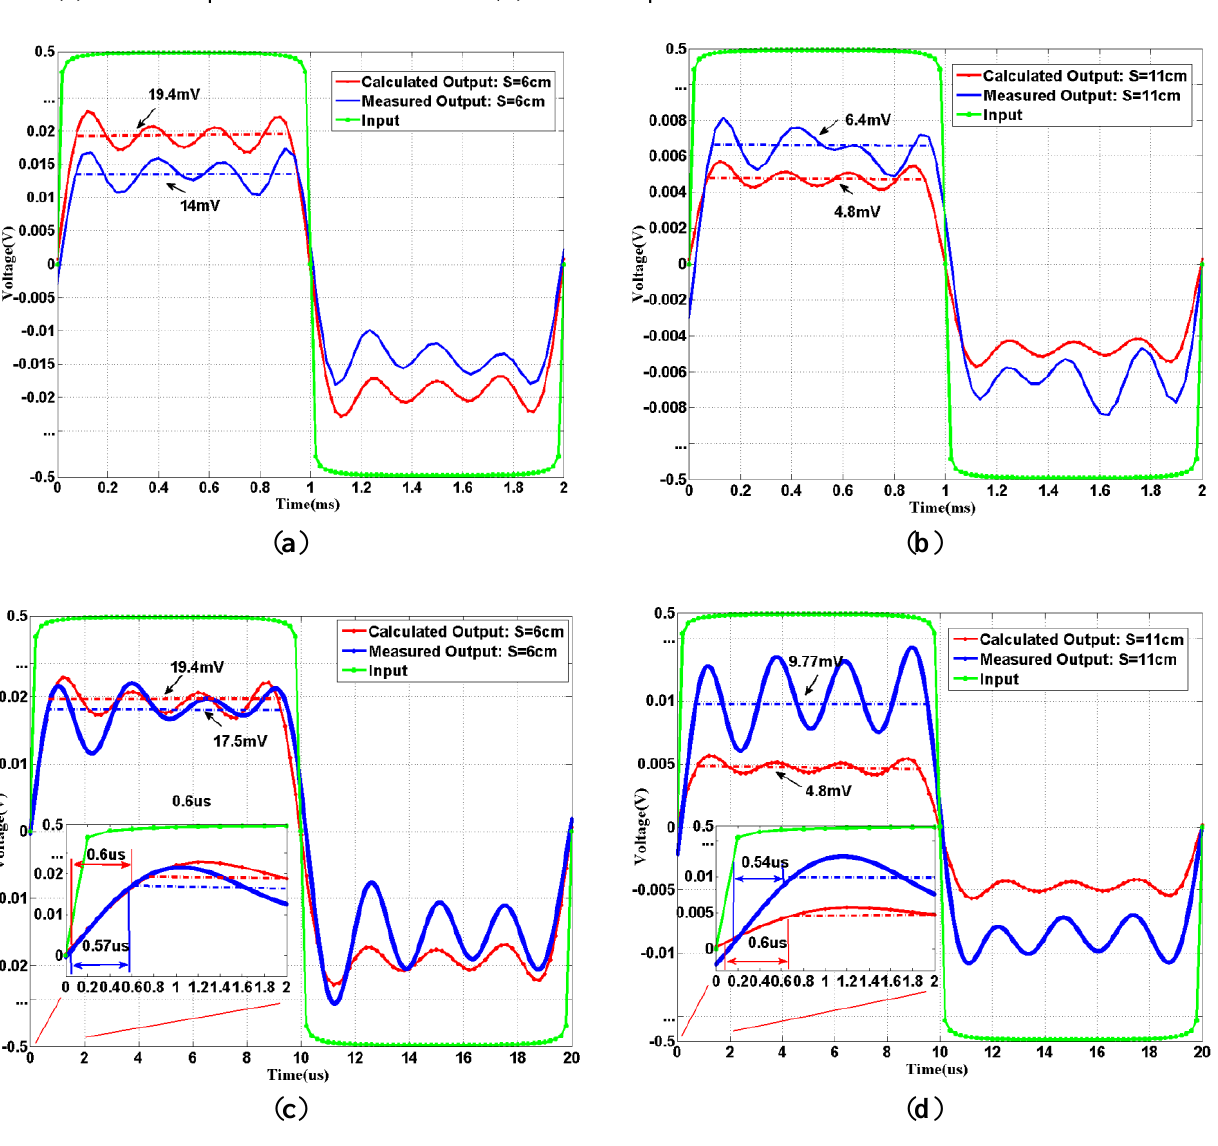
Figure 7. Input and Output (after demodulation) in passband IBC transmission for square wave: ( a ) 500 Hz square wave at S = 6 cm. ( b ) 500 Hz square wave at S = 11